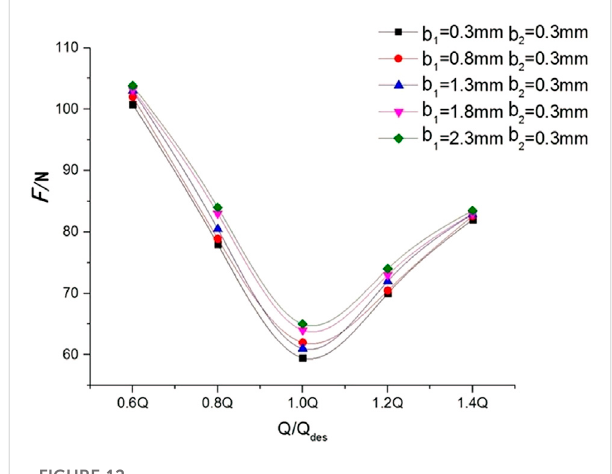
FIGURE 12 Radial force change of the CMP under different front wear-ring clearances.